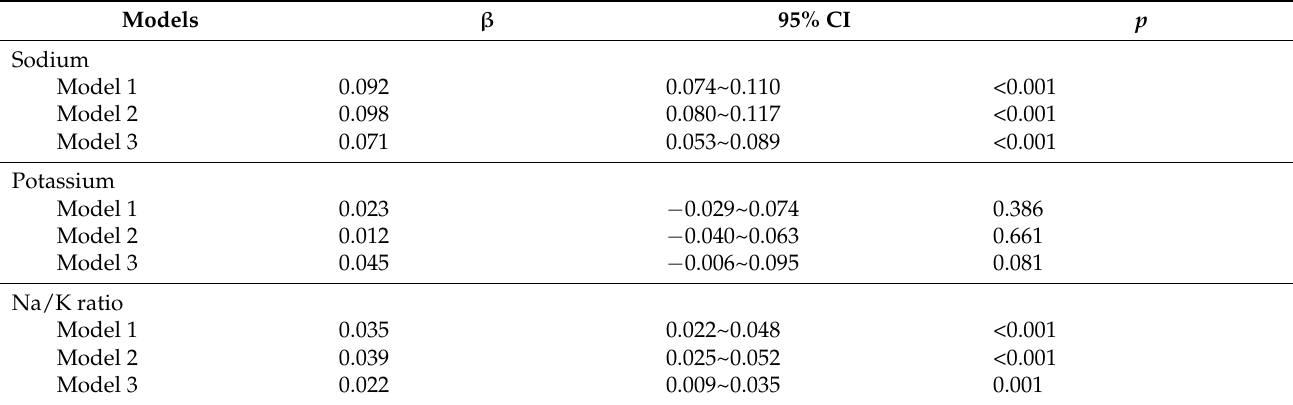
Table 3. Sensitivity analysis-Association of urinary index and urine albumin excretion rate (natural logarithmic transformed) using the mixed linear model.